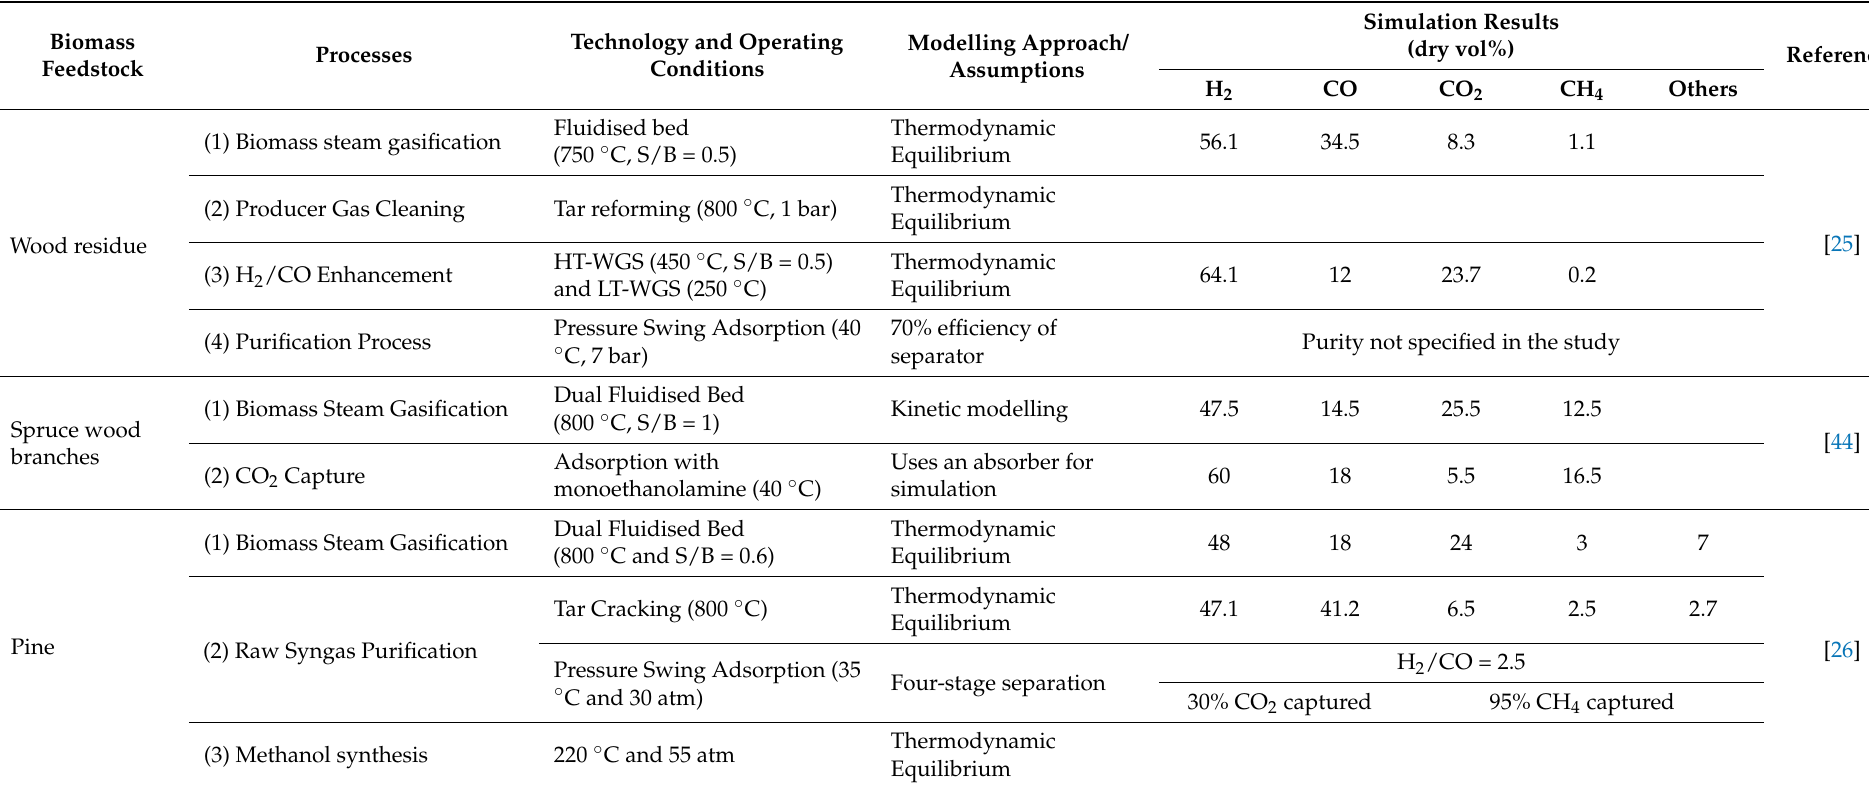
Table 8. Integrated Aspen Plus models of biomass gasification with subsequent gas